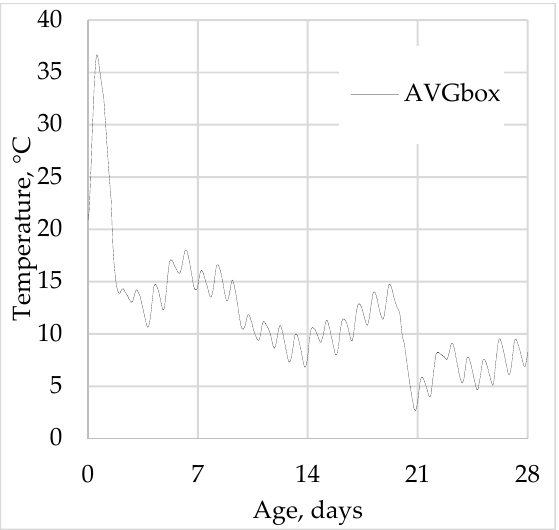
Figure 8. Internal temperature in the boxes (average value).